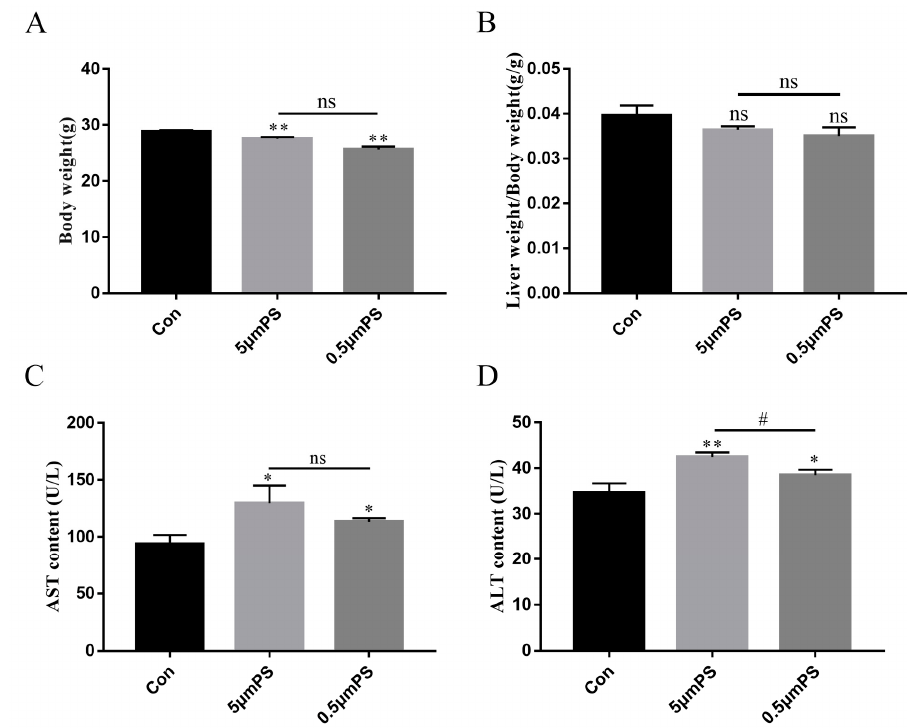
Figure 1. The effect of PS-MPs on body and liver weights. ( A ) Absolute body weight of control and PS-MP-exposed mice. ( B ) Relative uninjured liver wet weight of adult control and PS-MP-exposed mice. ( C ) Serum AST levels in mice. ( D ) Serum ALT levels in mice. Results are shown as mean ± SD ( n = 3). Compared with the control group, * p < 0.05, ** p < 0.01. Compared with the 0.5 µ m PS-MPs group, # p < 0.05. ns indicates not statistically signi fi cant.